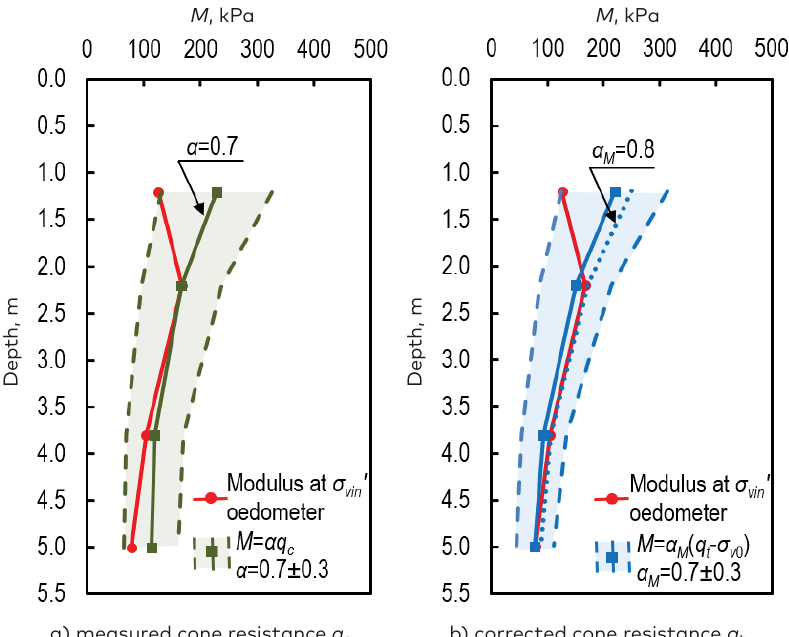
Figure 6. The constrained modulus of peat from the oedometer and CPTU tests determined on the basis of the measured cone resistance q c and corrected cone resistance q